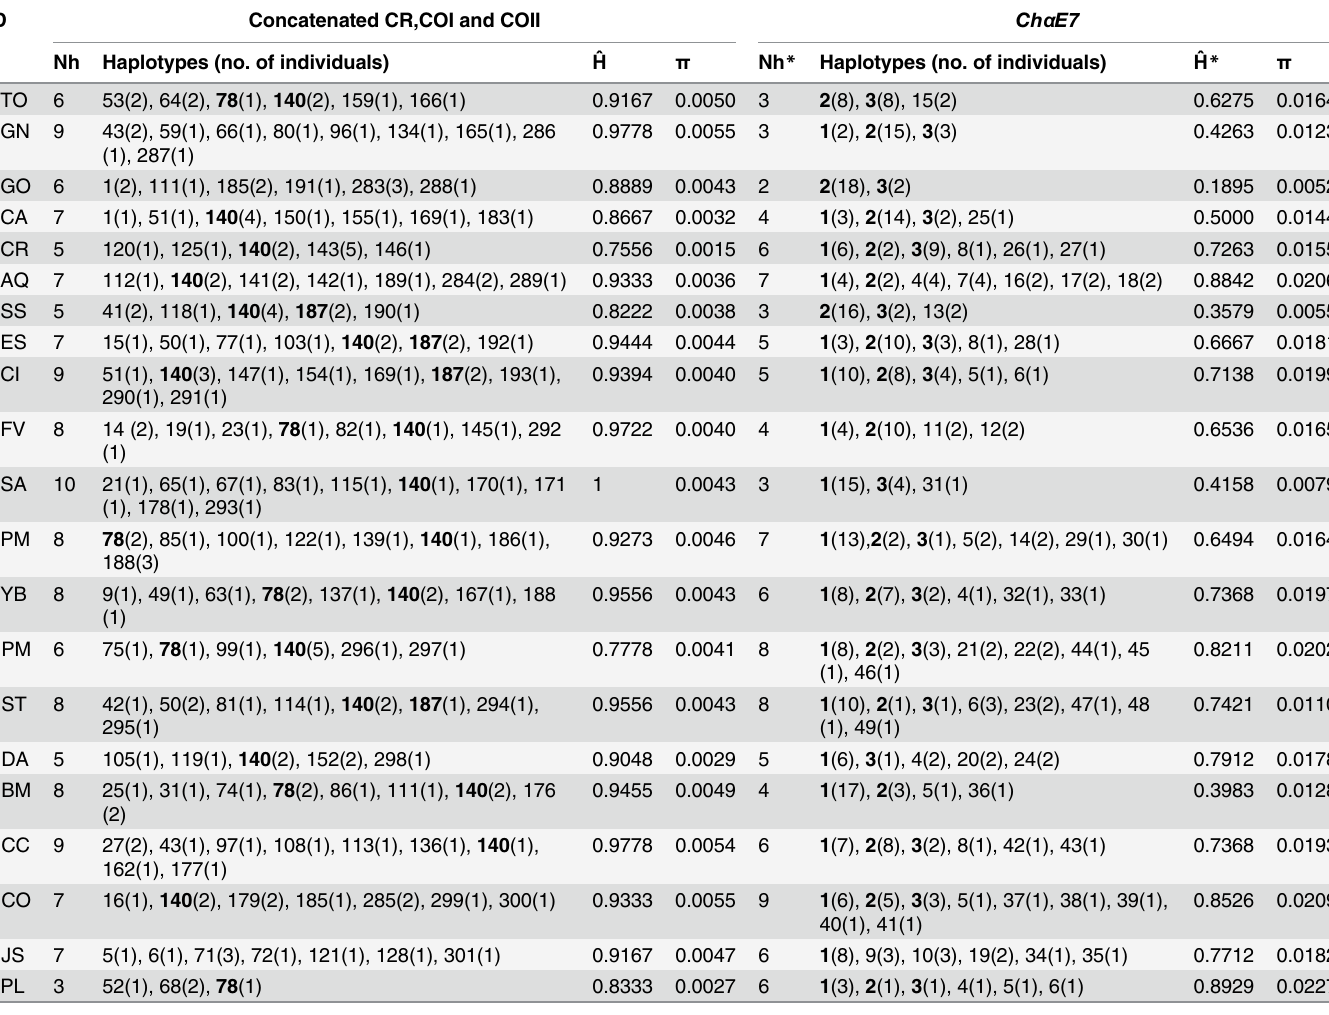
Table 3. General diversity indices for mitochondrial CR, COI, COII and Ch α E7 data in NWS fly sampling locations.